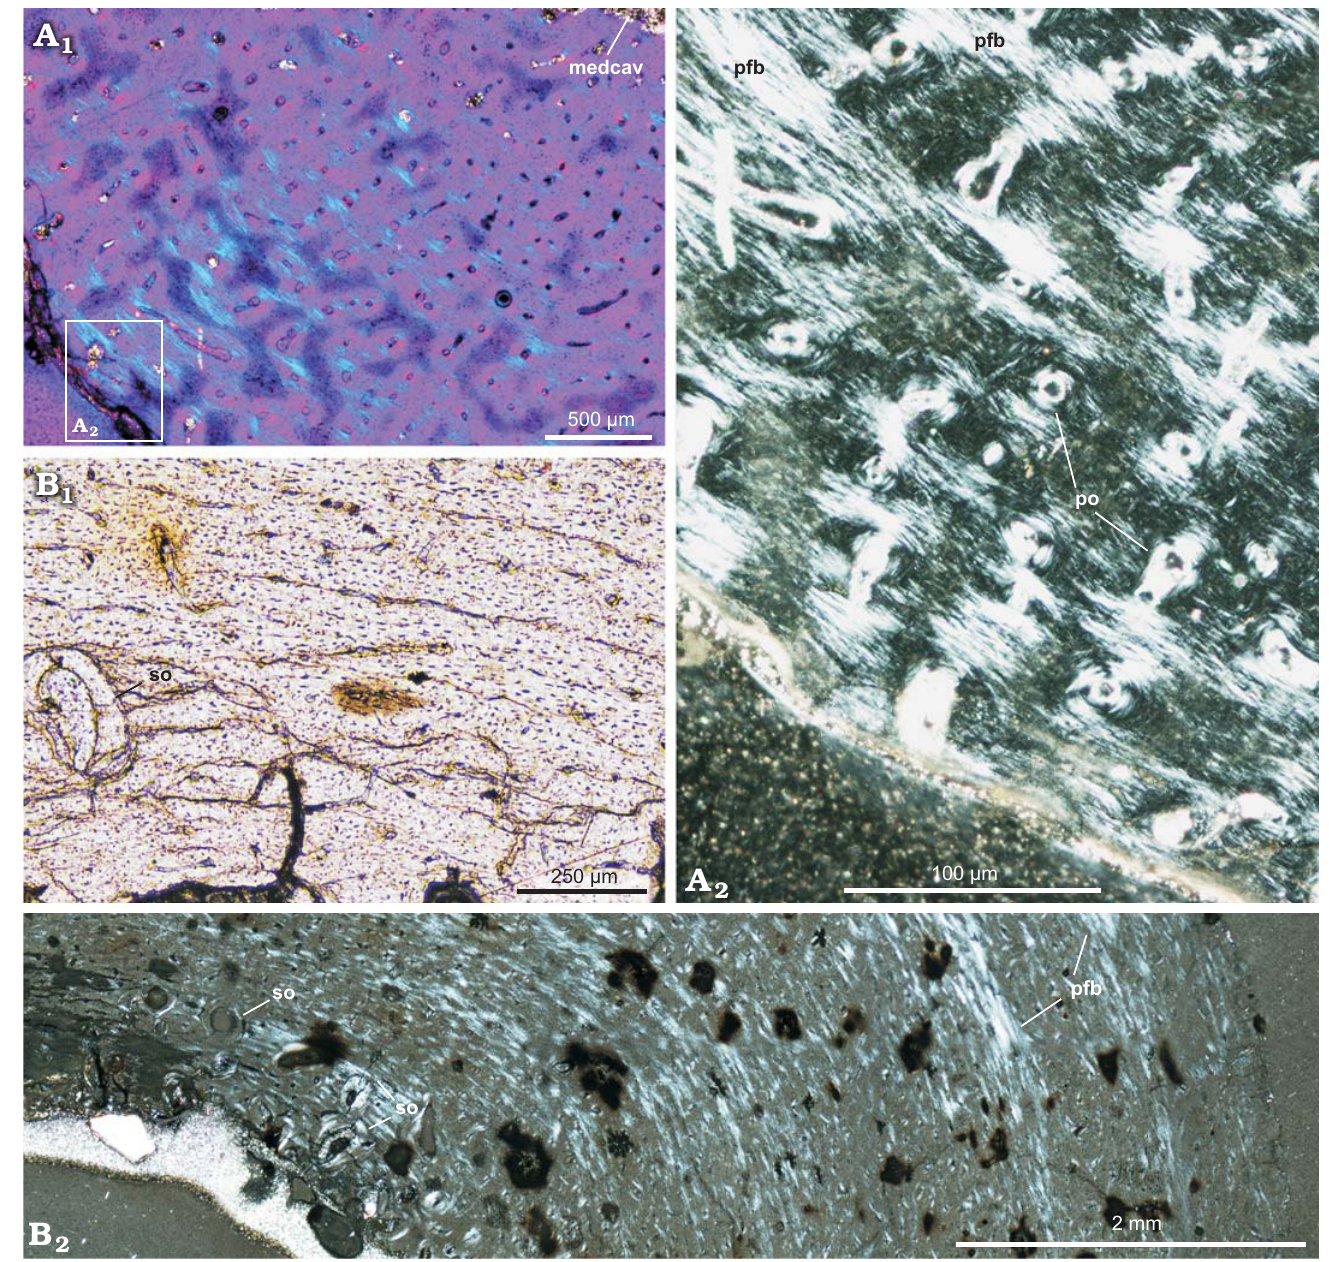
Fig. 2. Long bones microstructure of Protoceratops andrewsi Granger and Gregory, 1923, Bayn Dzak, Mongolia, Late Cretaceous. A . The shaft of the juvenile femur (ZPAL MgD-II/407) formed by a woven-fibered bone tissue; A 2 , detail of A 1 . B . The shaft of the subadult tibia (ZPAL MgD-II/35c) showing scarce erosion lacunae in the perimedullar region; B 1 , detail of B 2 . A 1 , B 2 , polarized light; A 2 , polarized light (quartz wedge); B 1 , normal